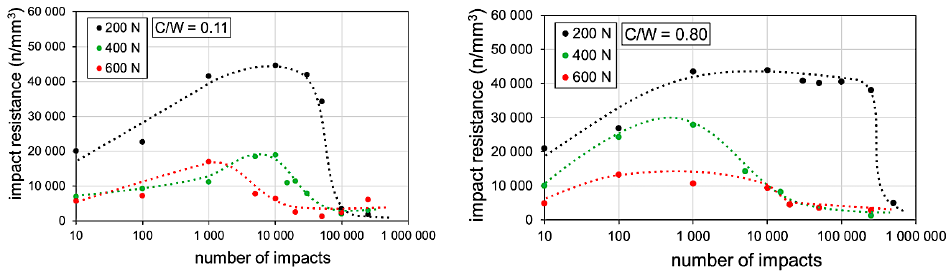
Figure 4. Impact resistance of the W-B-C coatings. Dotted lines were added as a visual guide.